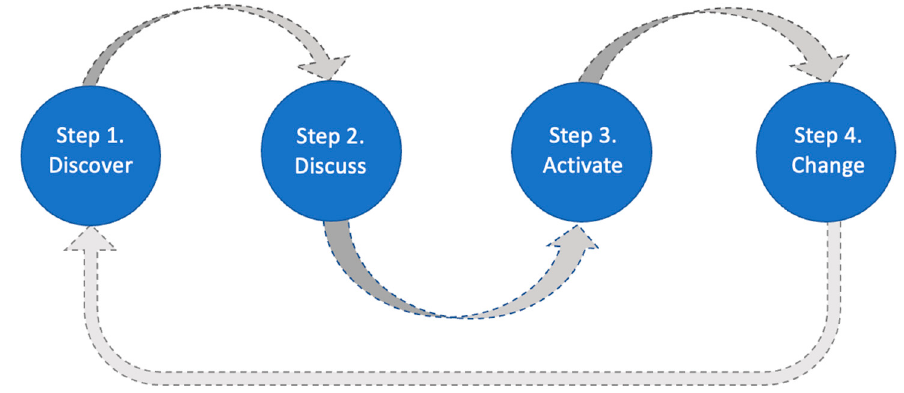
Figure 1. The OV four-step